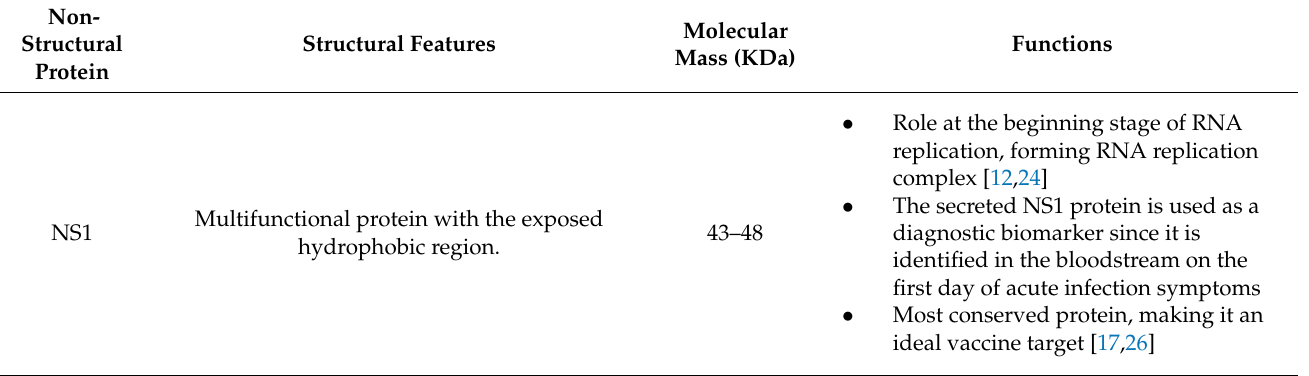
Table 1. Structural features of DENV non-structural proteins and their respective functions. Non- Structural Structural Features Protein